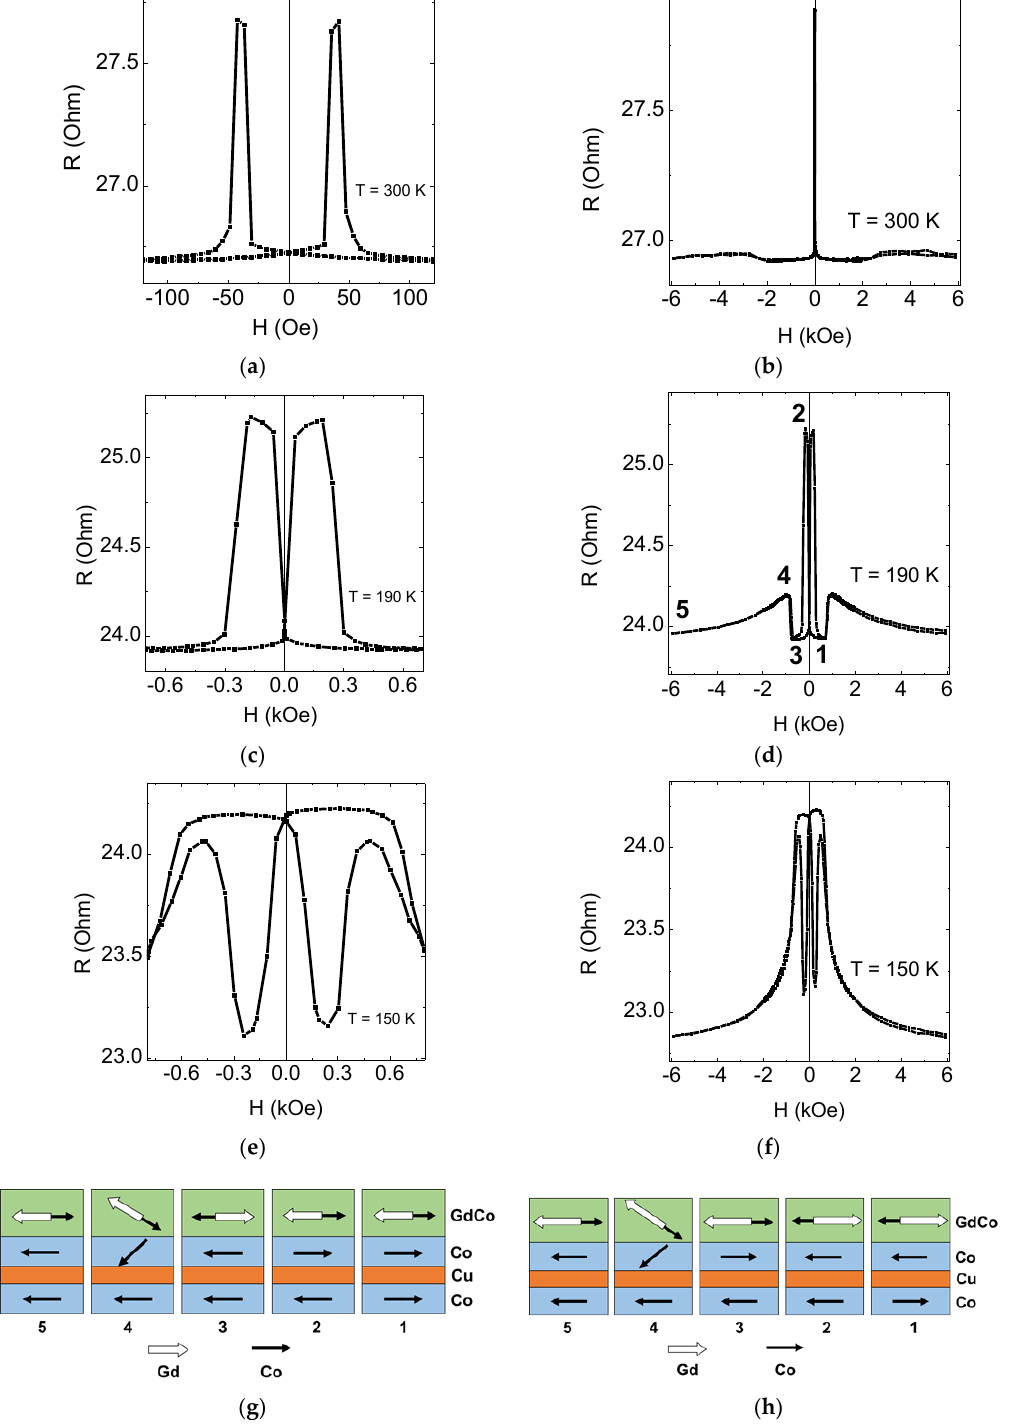
Figure 2. Magnetoresistance loops ( a – f ) for Gd-Co(35 nm)/Co(7 nm)/Cu(4 nm)/Co(7 nm) spin valve measured at different temperatures. ( a , c , e ) show low field part of MR hysteresis loops on enhanced scale. Schematic configurations of magnetic moments of pure Co layers as well as Co and Gd sublattices of the Gd-Co layer ( g , h ). At T > T*, the moment of Co total sub-network for Gd-Co(35 nm)/Co(7 nm) bilayer is larger than that of Gd sublattice of the Gd-Co(35 nm) layer ( g ), and vice versa at T < T* the magnetic moment of the Gd sub-lattice dominates over that of the Co sub-network ( h ).